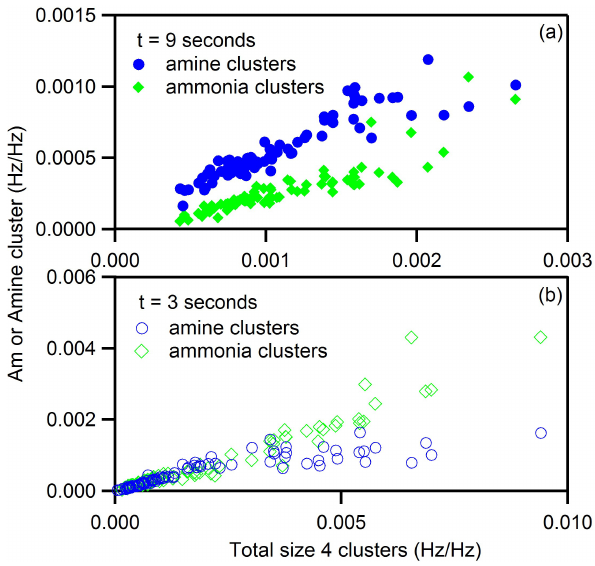
Fig. 3. Concentration of amine clusters (blue) (clusters contain both 4 H 2 SO 4 and 1amine molecule and masses of amines are 45, 59, 73 or 87amu) or ammonia clusters (green) (clusters contain both 4 H 2 SO 4 and 1–2ammonia molecules) versus total concentration of size 4 clusters. The total size 4 clusters include sulfuric acid cluster ( m/z 391), sulfuric acid-ammonia clusters ( m/z 408 and 425), and sulfuric acid-amine clusters ( m/z 436, 450, 464 and 478). Mea- surements were carried out at the Foothills laboratory of NCAR in Boulder, Colorado. (a) residence time=9s (solid); (b) residence time=3s (open).